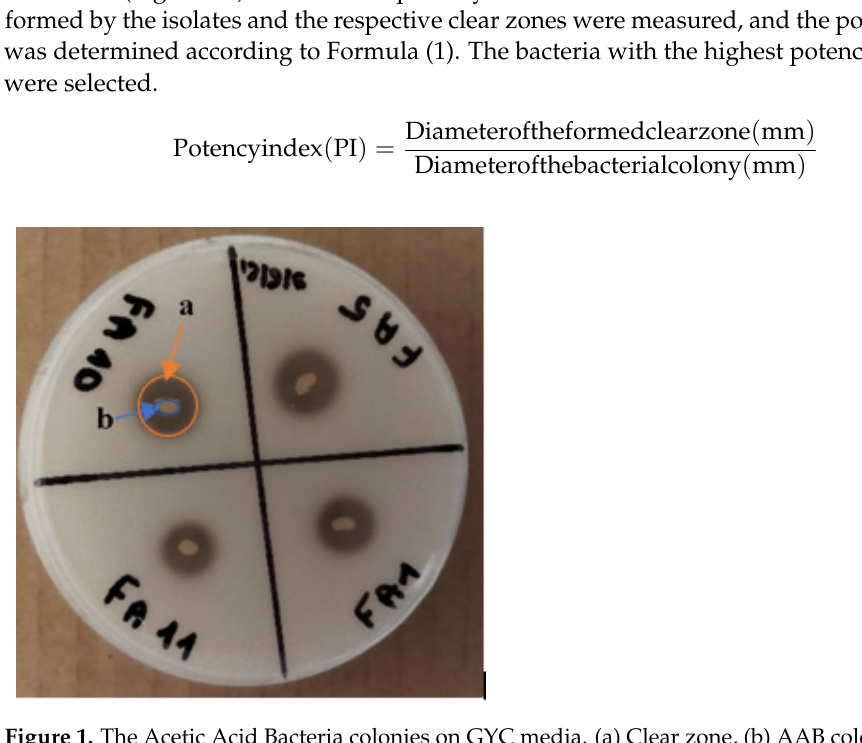
Figure 1. The Acetic Acid Bacteria colonies on GYC media. (a). Clear zone, (b). AAB